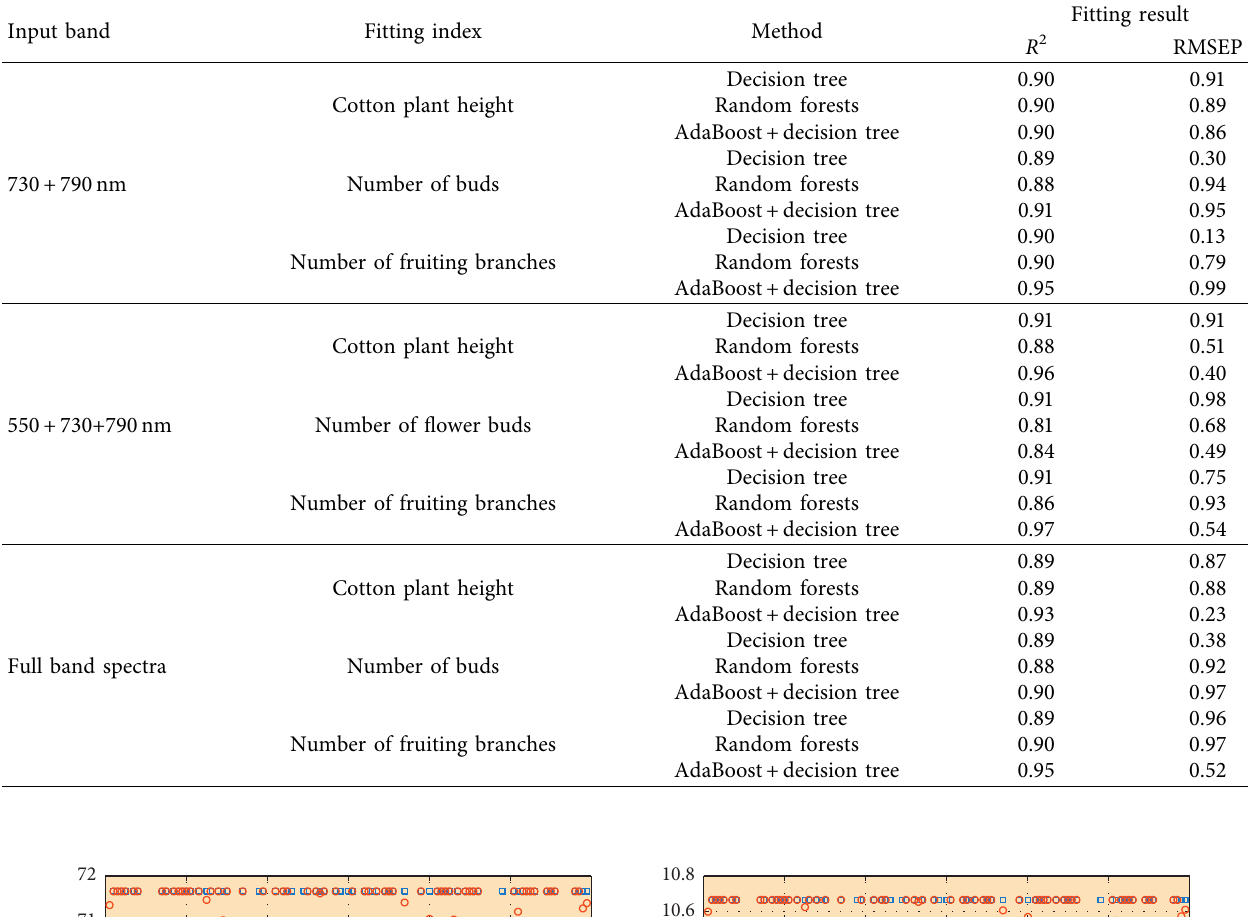
Table 4: The regression of the combinations band and the cotton of plant height, buds, and fruiting branches with decision tree, random forests, and AdaBoost +decision